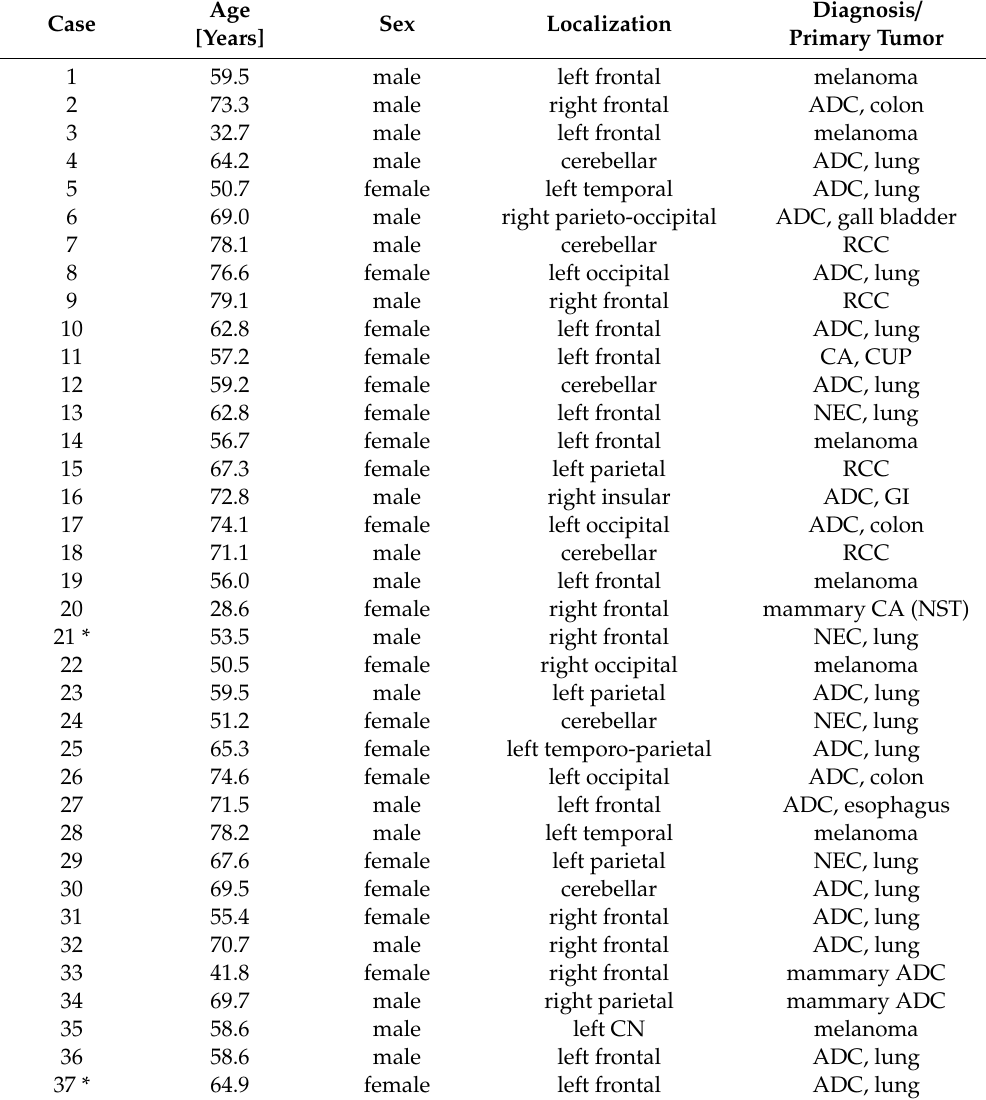
Table 1. Patient